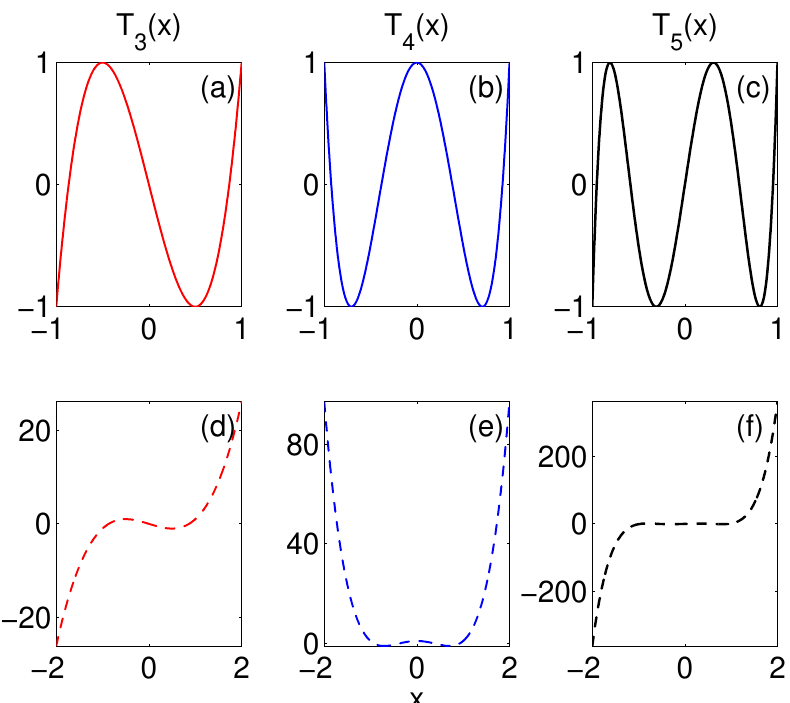
( x ) for k = 3 (red lines), k = 4 (blue lines), Figure 7: Chebyshev polynomials T k k = 5 (black lines). The first row ((a-c) with solid lines) illustrates the oscillations ( x ) inside the interval [ − 1,1 ] while the second row ((d-f) with dashed lines) of T k shows the rapid increase outside [ − 1,1 ] of Chebyshev